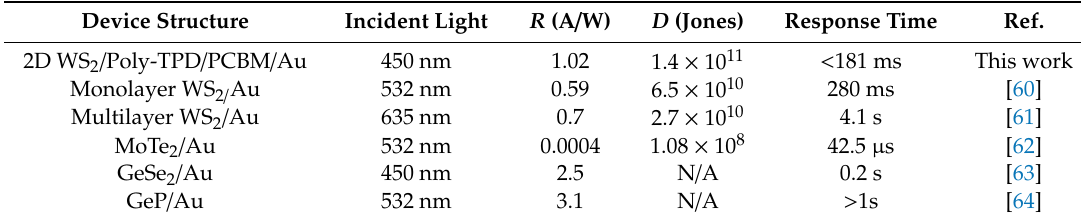
Figure 5. Performance of the WS 2 / Poly-TPD / PCBM-based photodetector. ( a ) Source-drain current ( I D ) versus drain voltage ( V D ). ( b ) I D versus gate voltage ( V G ) curves of the photodetector in dark (black line) and under laser (red line). ( c , d ) Responsivity and detectivity curves and the external quantum e ffi ciency (EQE) of the device as a function of V G ranging from − 30 V to 20 V. Measurements were performed at room temperature with a laser at 450 nm. The light intensity was 0.14 mW / cm 2 . The V G was 0 V in (a), and the V D was 15 V in (b–d). Table 1. Photoresponse parameters of di ff erent materials and